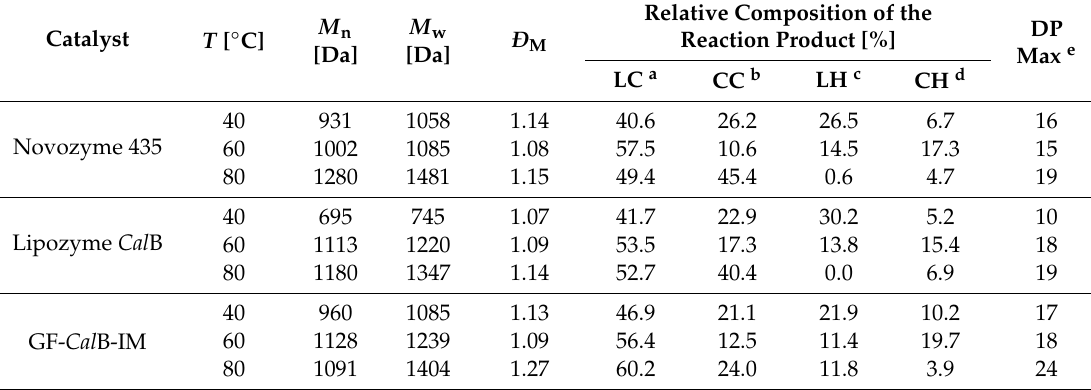
Figure 2. The MALDI TOF-MS spectrum of the copolymer synthesized from 5-hydroxymethyl furanoic acid (HMFA) and ε -Caprolactone (ECL) at 80 °C and 24 h reaction time, without solvent; Linear copolymers (triangles); Cyclic copolymers (squares). Table 1. The influence of the biocatalyst and temperature on the relative copolymer and homopolymer content of the reaction